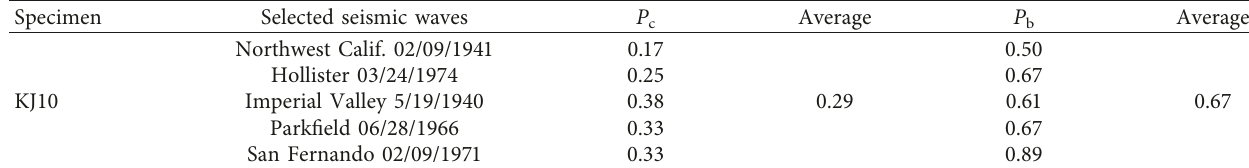
Table 22: Plastic hinge rates of beams and columns in model KJ10.